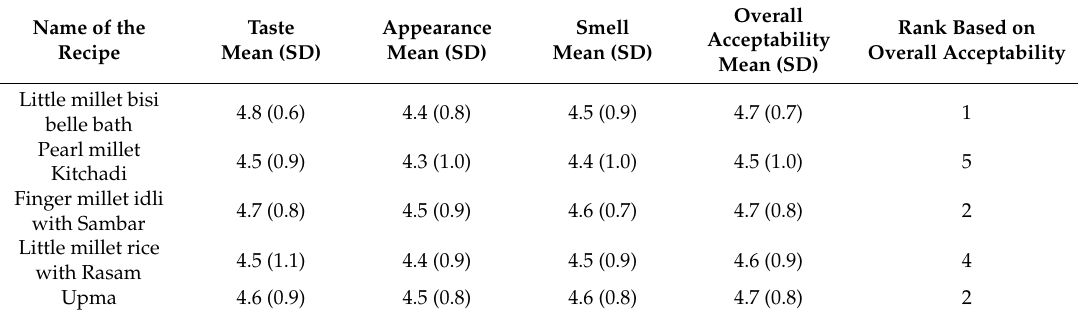
Table 6. Preference and acceptability of recipes based on sensory attributes.